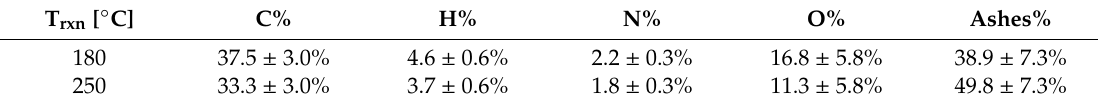
Table 5. Ultimate analysis (dry basis) of hydrochar (HC) for the two investigated temperatures. T rxn [ ◦